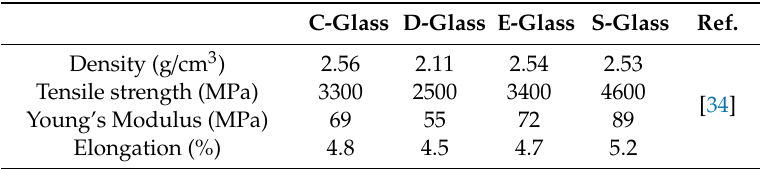
Table 2. Mechanical properties of glass fibre types C, D, E and S.